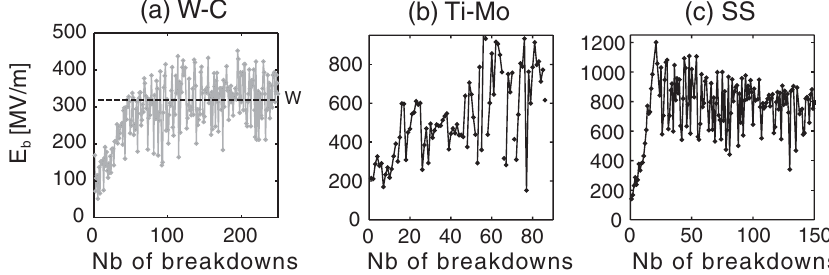
FIG. 4. Conditioning curves of other alloys: tungsten carbide, titanium-molybdenum, and stainless